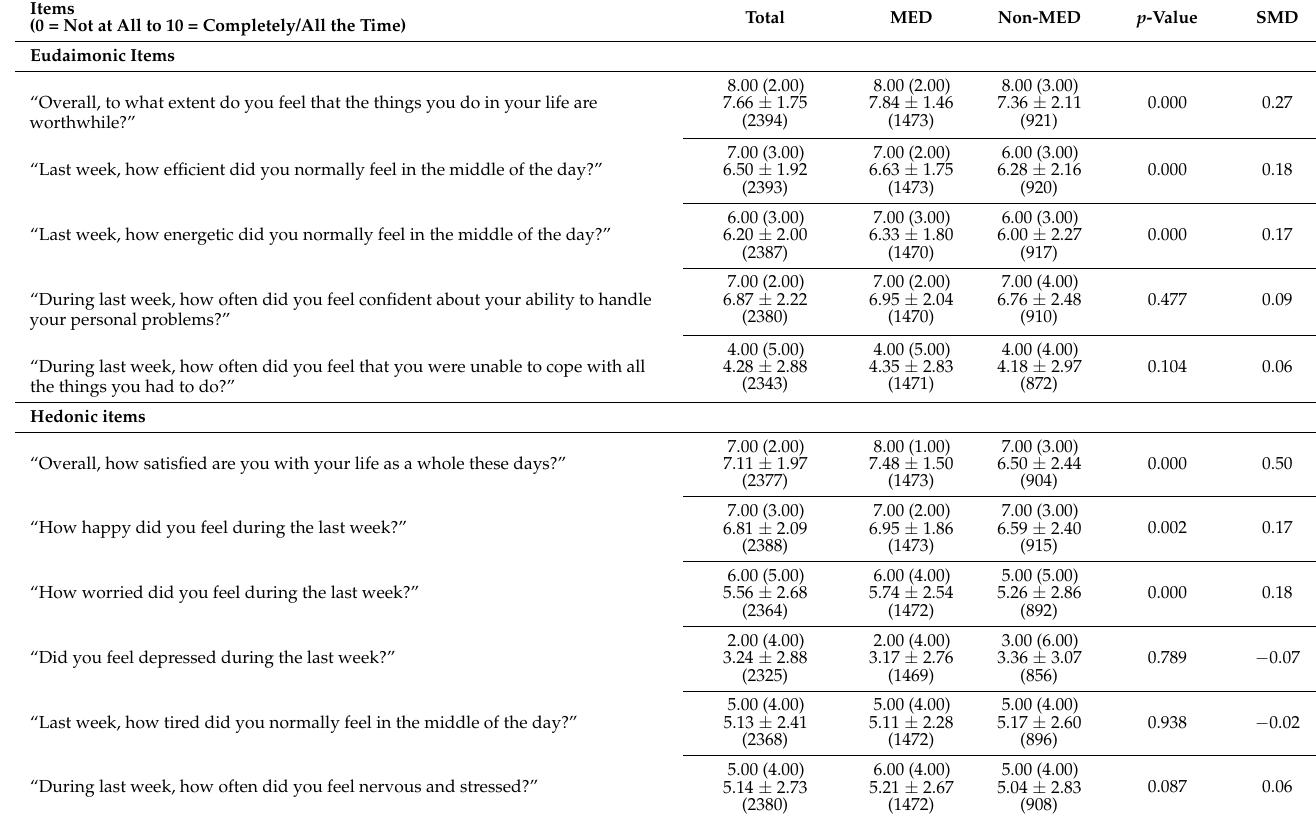
Table 3. Scoring for the individual hedonic and eudemonic items: total population, MED and non-MED